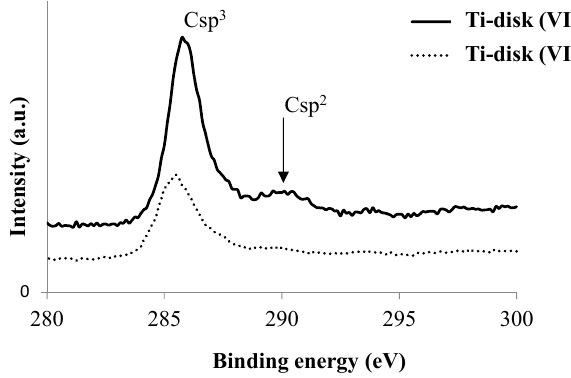
Figure 2. C1s X-ray photoelectron spectroscopy (XPS) spectra of Ti disk (VI) and Ti disk (VII).